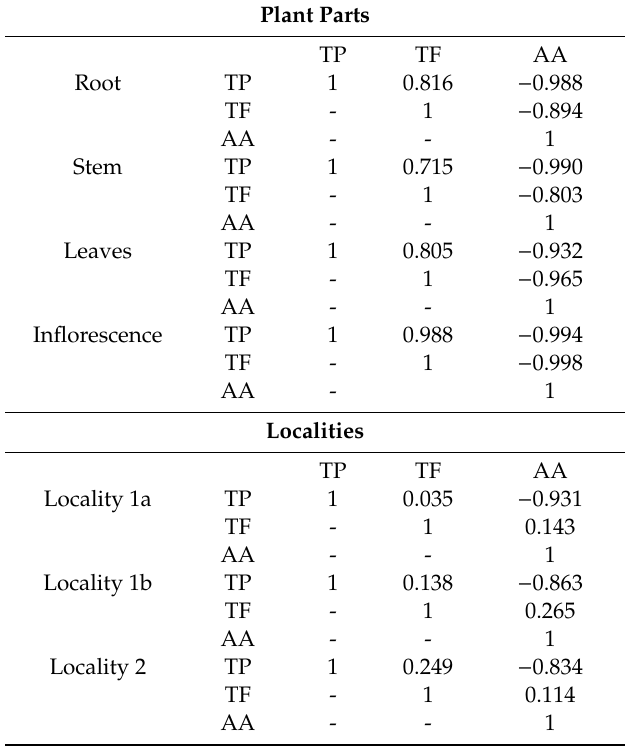
Table 4. Correlation coe ffi cient (r) between the quantity of TP (total phenolic compounds), TF (total flavonoids), and AA (antioxidant activity) comparing plant parts and